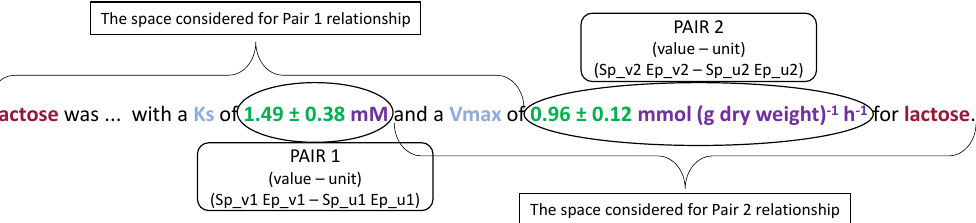
Figure 6: Example of a sentence where two value-unit pairs were identified. Annotated entities from “metabolites” (dark red) and “kinetic parameters” (light blue) classes are shown. SP v and Ep v are, respectively, start and end positions of the value in the sentence; Sp u and Ep u represent the same for the unit parameter.